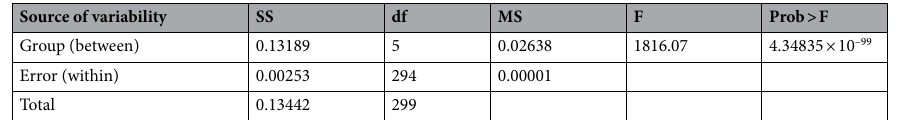
Table 2. The results of the ANOVA, where each from 6 groups represent the set of average RI of goblet cells interior, connective tissue and immune cells for healthy control and post-mortem samples. SS is a sum of squares due to each source, df degree of freedom associated with each source, MS mean squares for each source, F F statistics, Prob > F p-value which is the probability that F-statistic can take a value larger than computed F-statistic